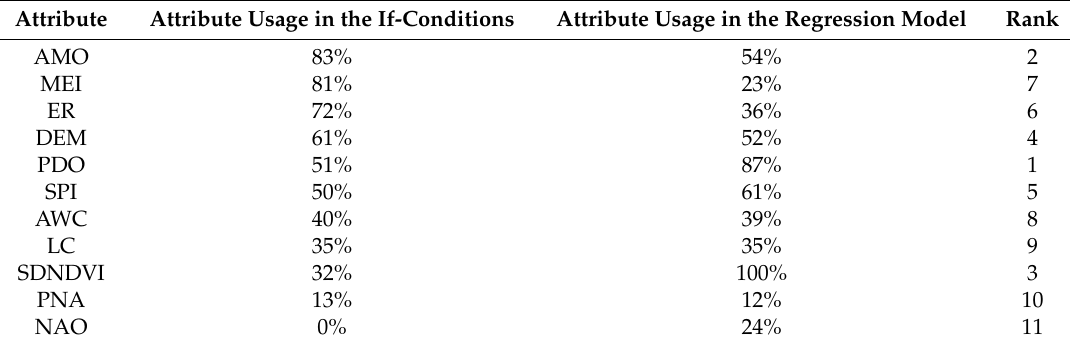
Table 2. Attribute usage assessment for drought prediction